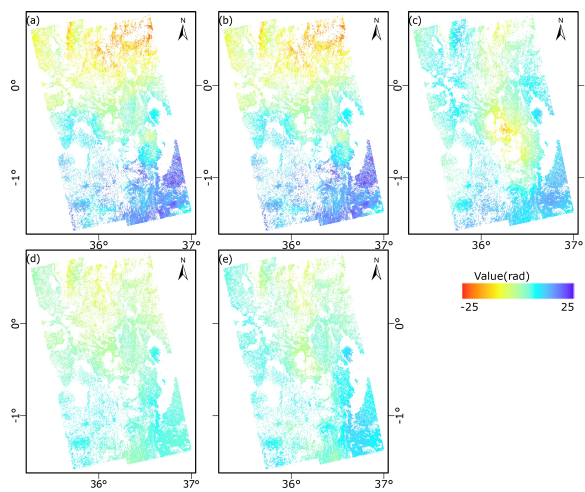
Figure 3. Evaluation of the spatial variability between the original short-interval interferogram and differential tropospheric delay estimates. The interferogram (a) is the original unwrapped interferogram (20180102 20180114), (b) is the corresponding SAR-based differential delay, while (c), (d), and (e) correspond to ERA-5, GACOS, and MERRA-2 differential delays, respectively.